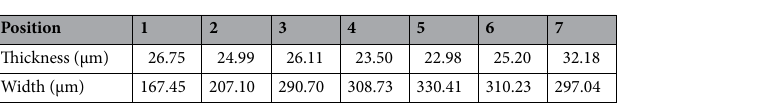
Table 1. Thicknesses and widths of the pst in different positions from Fig. 1b–j.